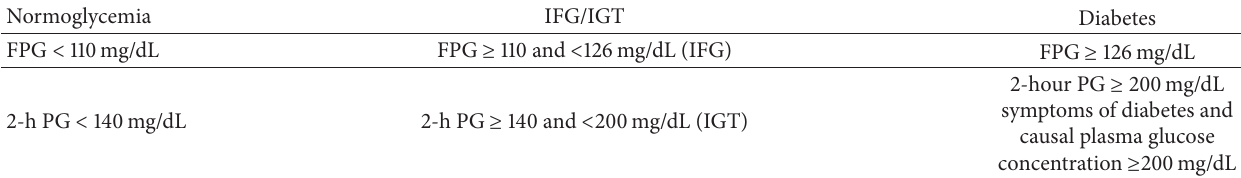
Table 1: Criteria of Indian Council of Medical Research (ICMR) for diagnosis of diabetes and glucose